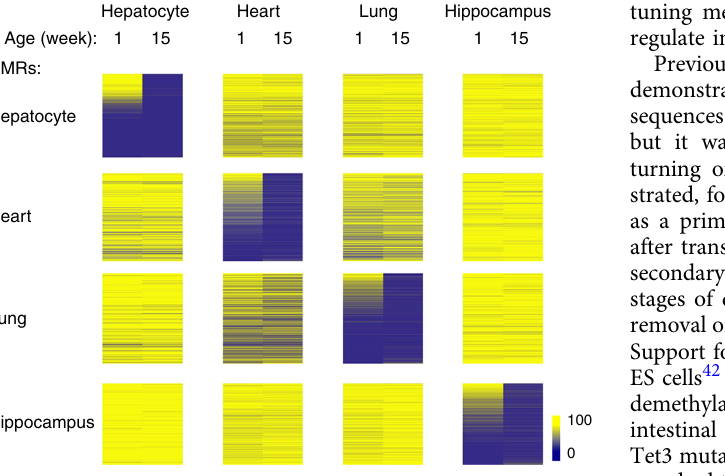
Fig. 7 Postnatal demethylation in various tissues. Methylation heatmap (RRBS) of hepatocyte-speci fi c ( n = 9408), heart-speci fi c ( n = 892), lung-speci fi c ( n = 914), and hippocampus-speci fi c ( n = 3630) DMRs ( p value <10 − 4 , permutation test) ranked according to newborn methylation levels in each